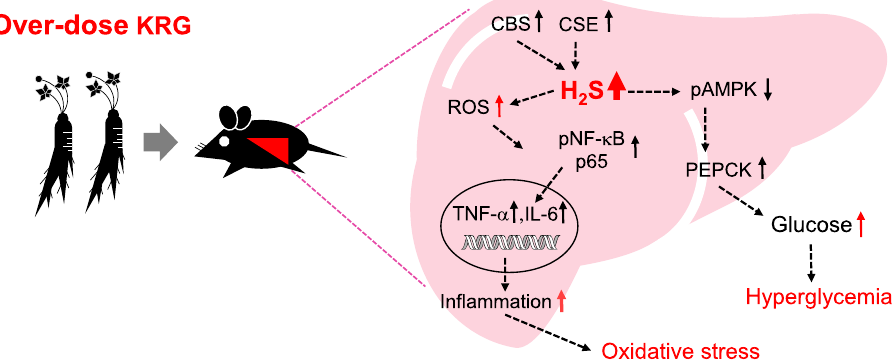
Figure 4. Signaling pathways underlying KRG-induced oxidative stress and hyperglycemia through H 2